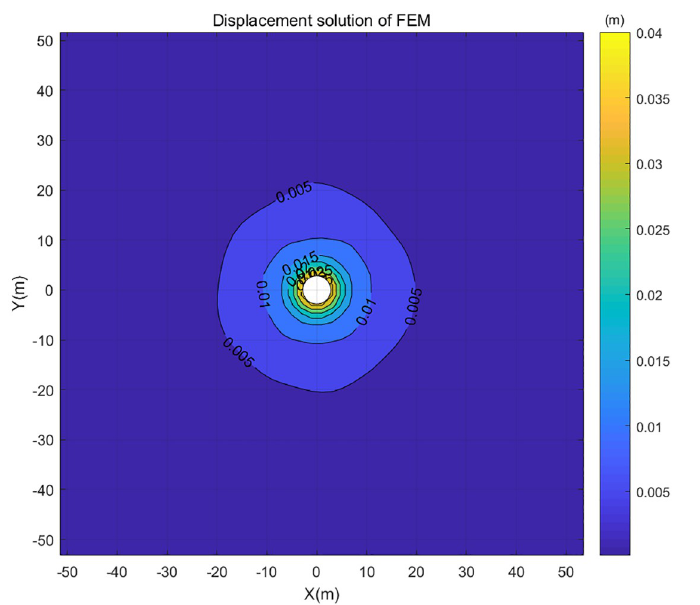
Fig 7. Displacement contour map of classical FEM within 50m center